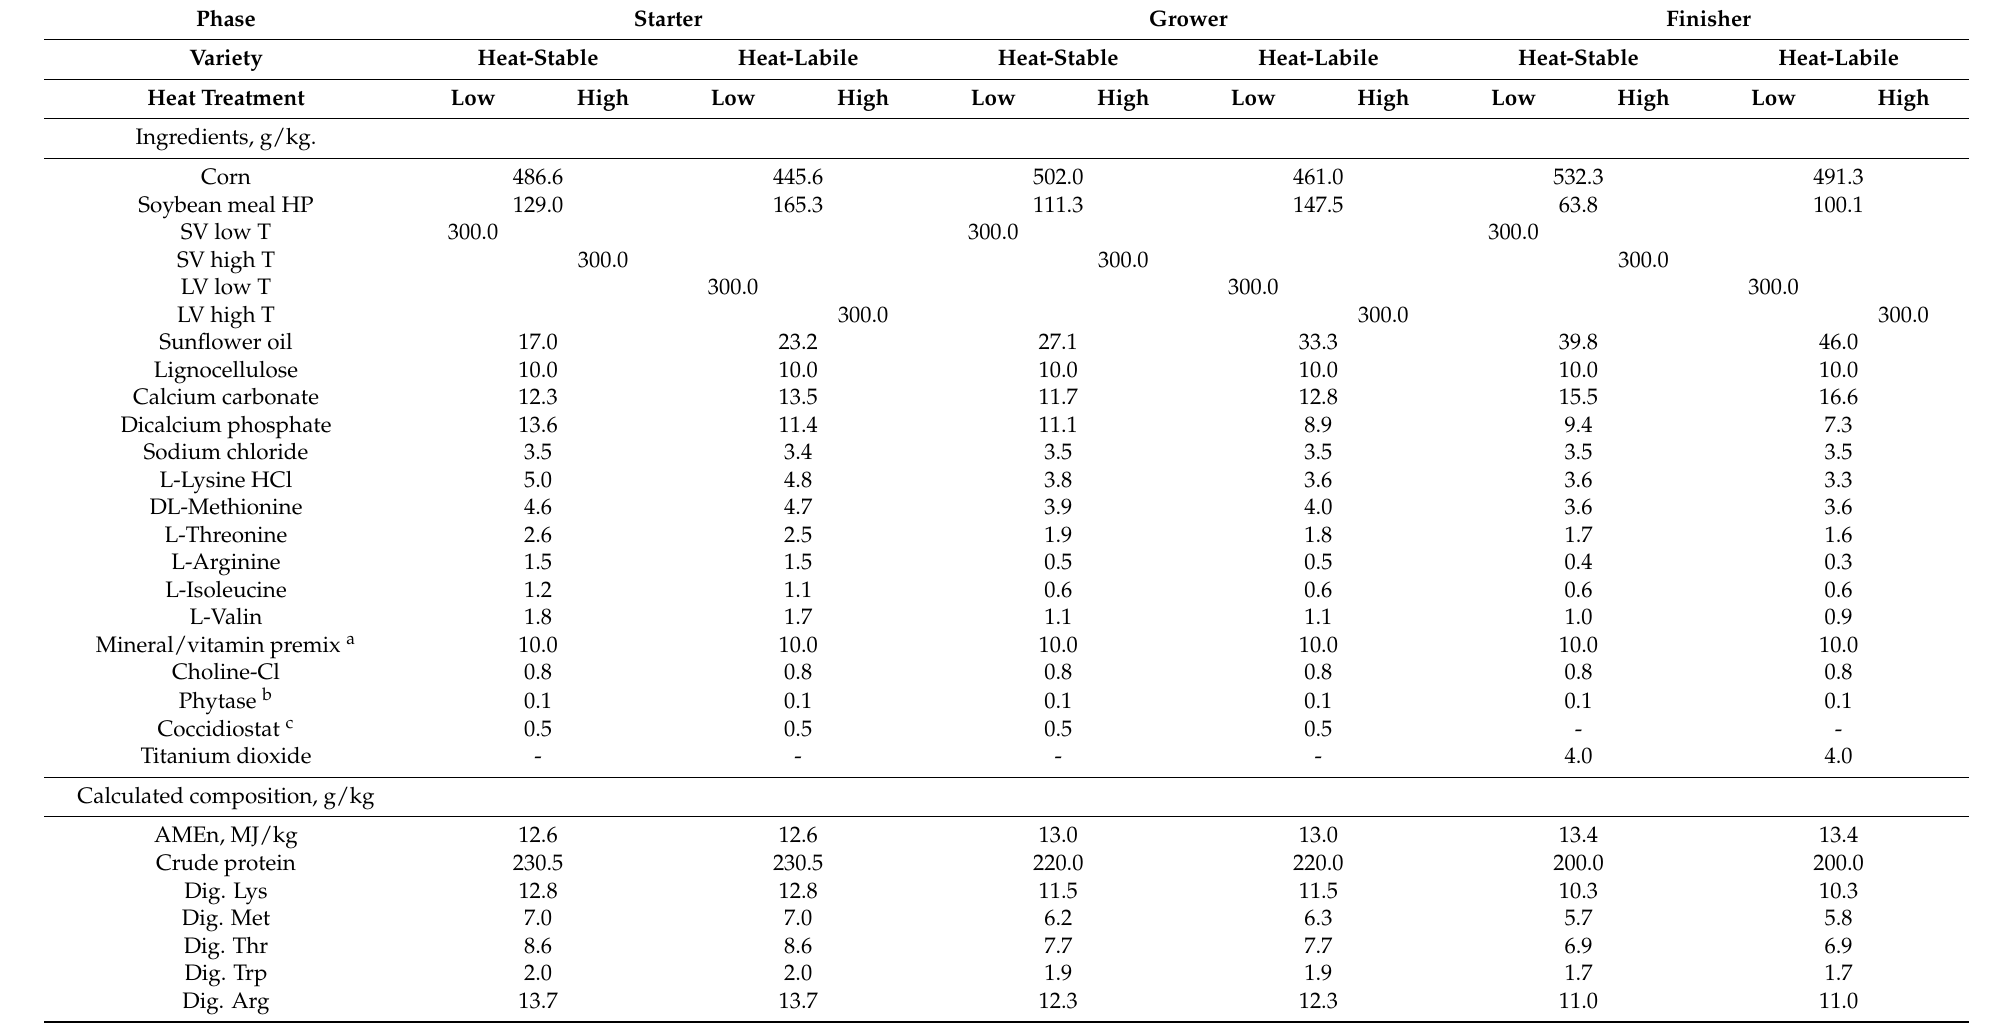
Table 1. Compositional details of the diets